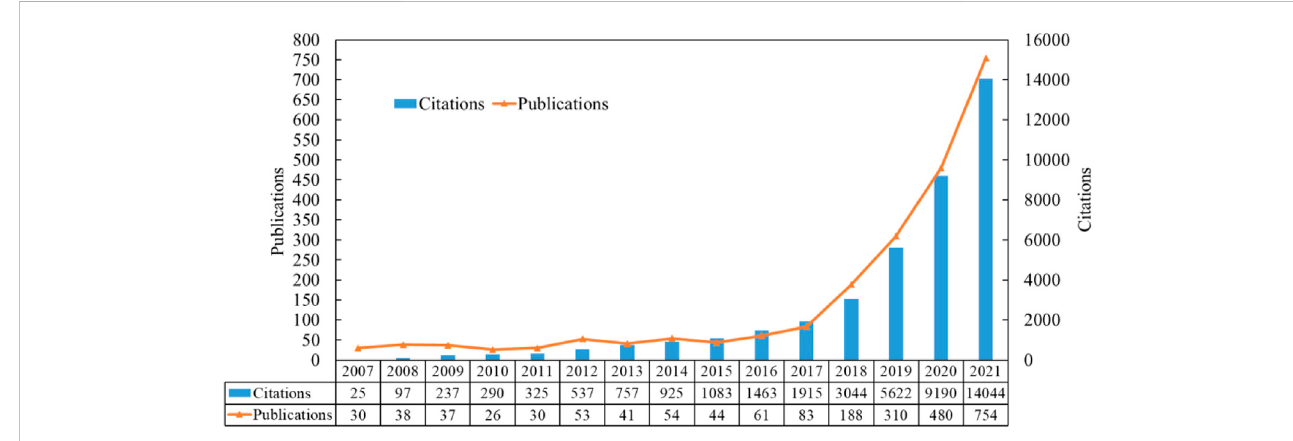
FIGURE 2 The annual distribution of publications and total citations on AI method applying in ECG research until 2021.